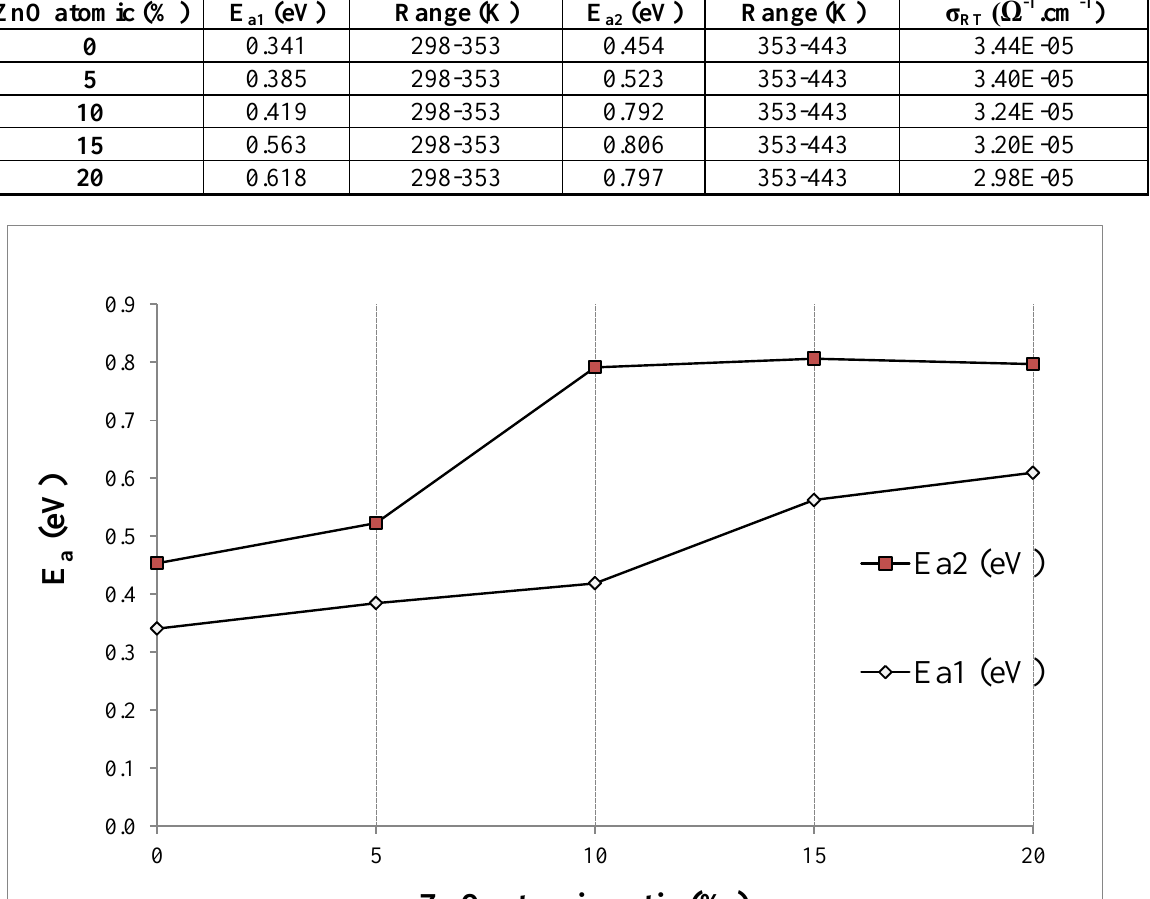
) (ZnO) thin 2 1-x x